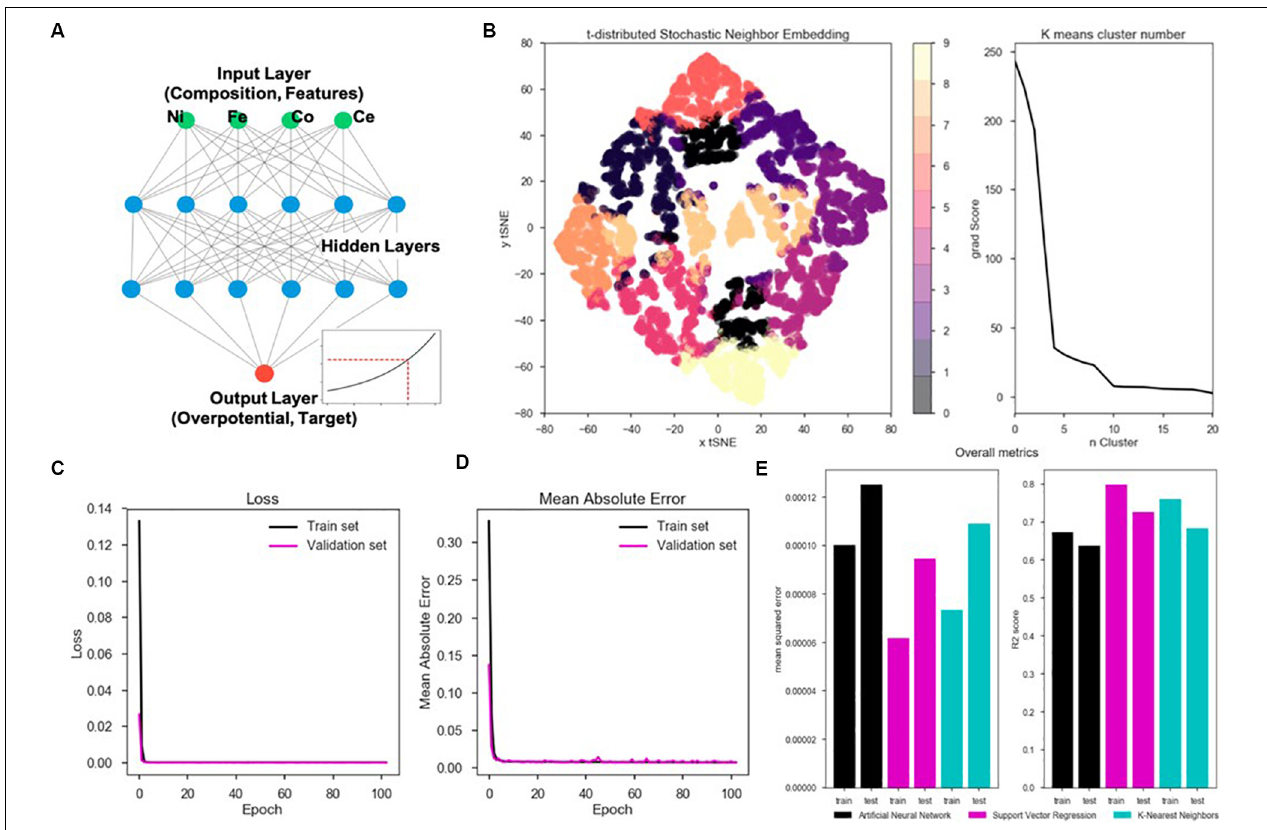
FIGURE 9 | (A) The operation mode of artificial neural network. (B) Unsupervised visualization of the data sets features with k-means clustering (right) and t-distributed stochastic neighbor embedding (left). (C,D) Loss and mean absolute error metrics of the used ANN plotted over the calculated epochs for the training set (black) and the validation set (magenta). (E) Metrics overview for all methods. Reproduced from Palkovits and Palkovits (2019) with permission from Copyright (2019) American Chemical